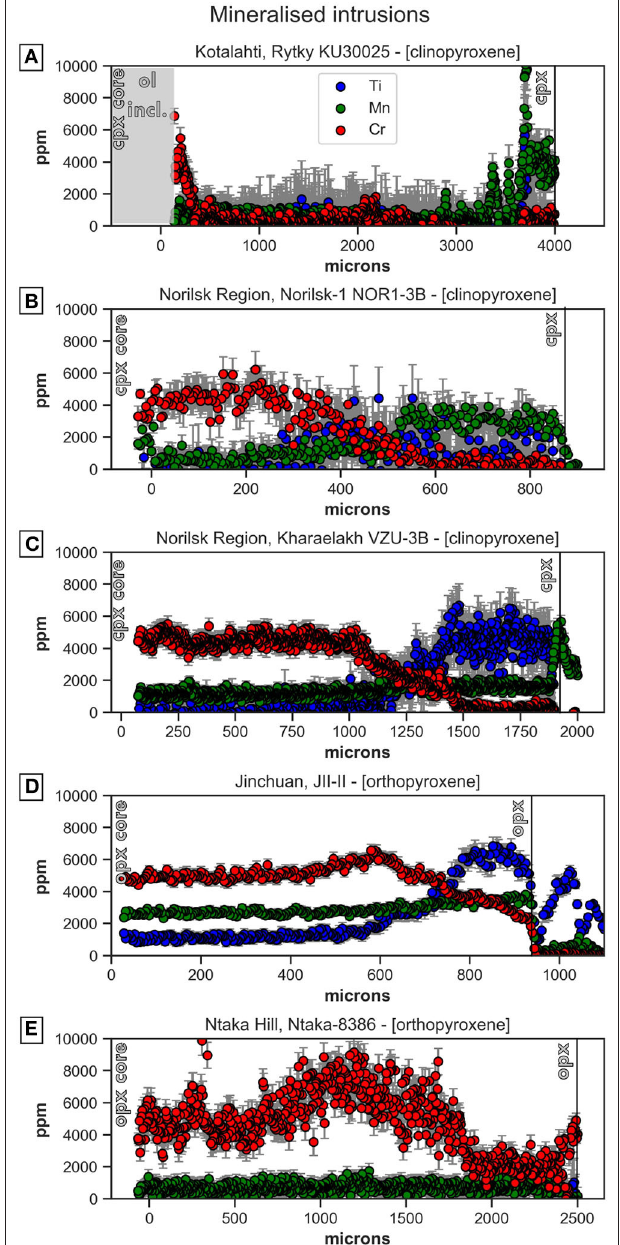
FIGURE 4 | Traverses across clinopyroxene and orthopyroxene from core to rim in mineralized intrusions. (A) Traverse through clinopyroxene from the Rytky intrusion, Kotalahti Ni-belt ( Figure 3A ). (B) Clinopyroxene from the Norilsk-1 intrusion of the Norilsk-Talnkah region. (C) Clinopyroxene from the Kharaelakh intrusion of the Norilsk-Talnakh region ( Figure 3C ). (D) An orthopyroxene from Jinchuan intrusion ( Figure 3G ). (E) An orthopyroxene from the Ntaka Hill intrusion in Tanzania ( Figure 3B